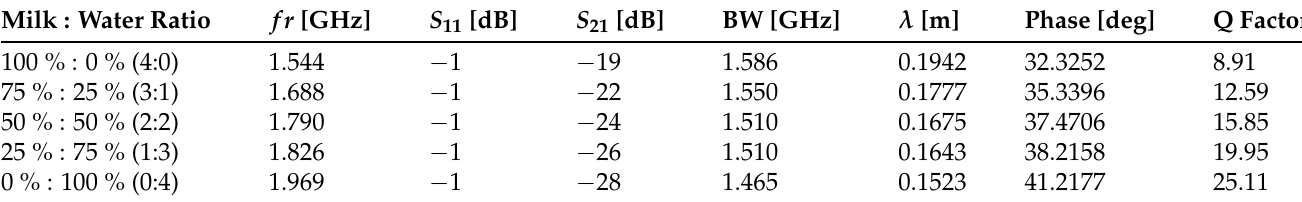
Figure 30. Adulteration testing in milk: ( a ) experimental setup, ( b ) variation in scattering parameters with frequency and ( c ) variation in transmission coefficient parameters with frequency. Table 12. Adulteration testing in milk.